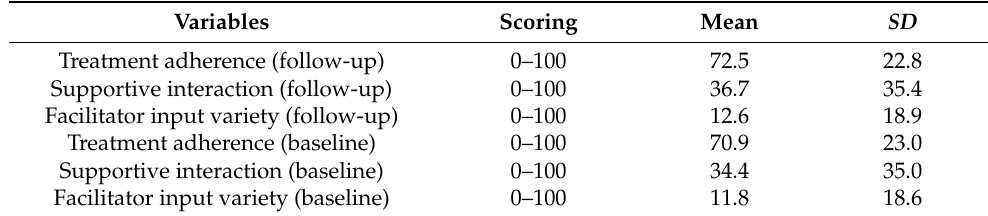
Table 2. Means and standard deviations ( N = 391).